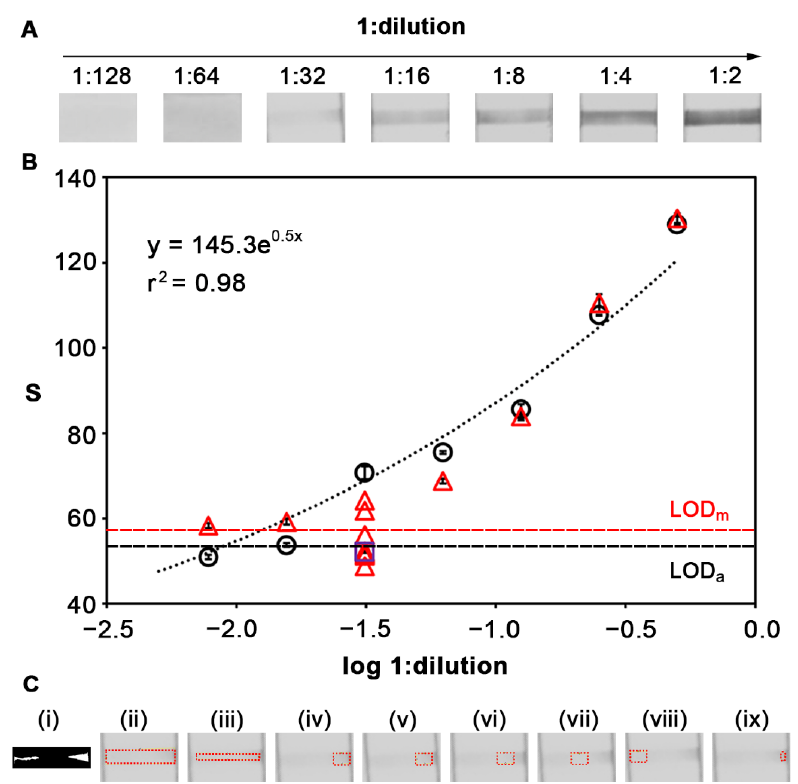
Figure 5. Colorimetric detection of LFIA for host antibodies against SARS-CoV-2: ( A ) Photographs of the assays; ( B ) signal quantification with the automated software (black dots) or the manual method (red triangles and purple square), where error bars are the standard deviation of 3 measurements on the same LFIA, LOD m is the limit of detection obtained with manual method, and LOD a is the one obtained with the automated software; ( C ) ROI for the 1:32 samples obtained with the automated software ( i ) or through manual selection that gives rise to the different results reported for sample 1:32 ( ii–ix ).